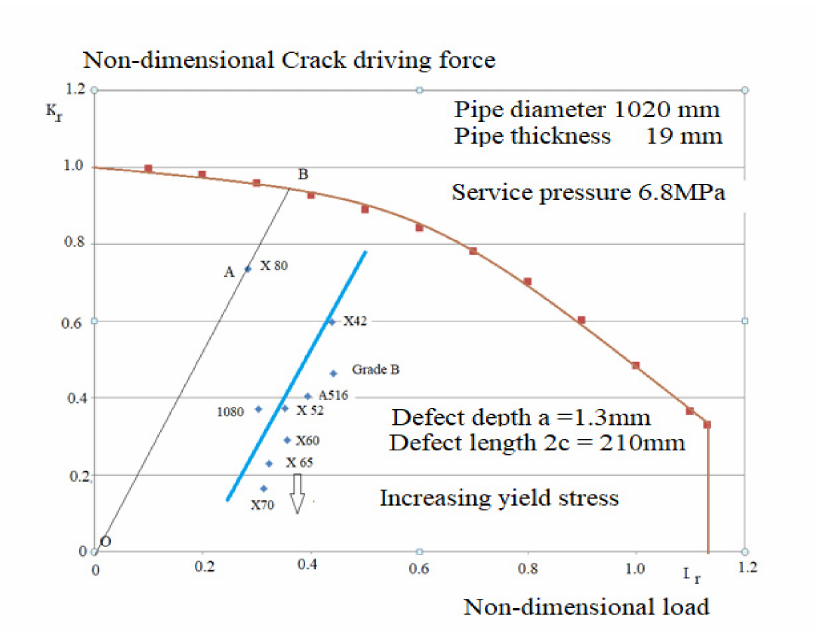
Figure 13. Assessment points of a semi-elliptical surface crack (depth 1.3mm, length 210 mm) for 10 pipe steels submitted to hydrogen embrittlement.